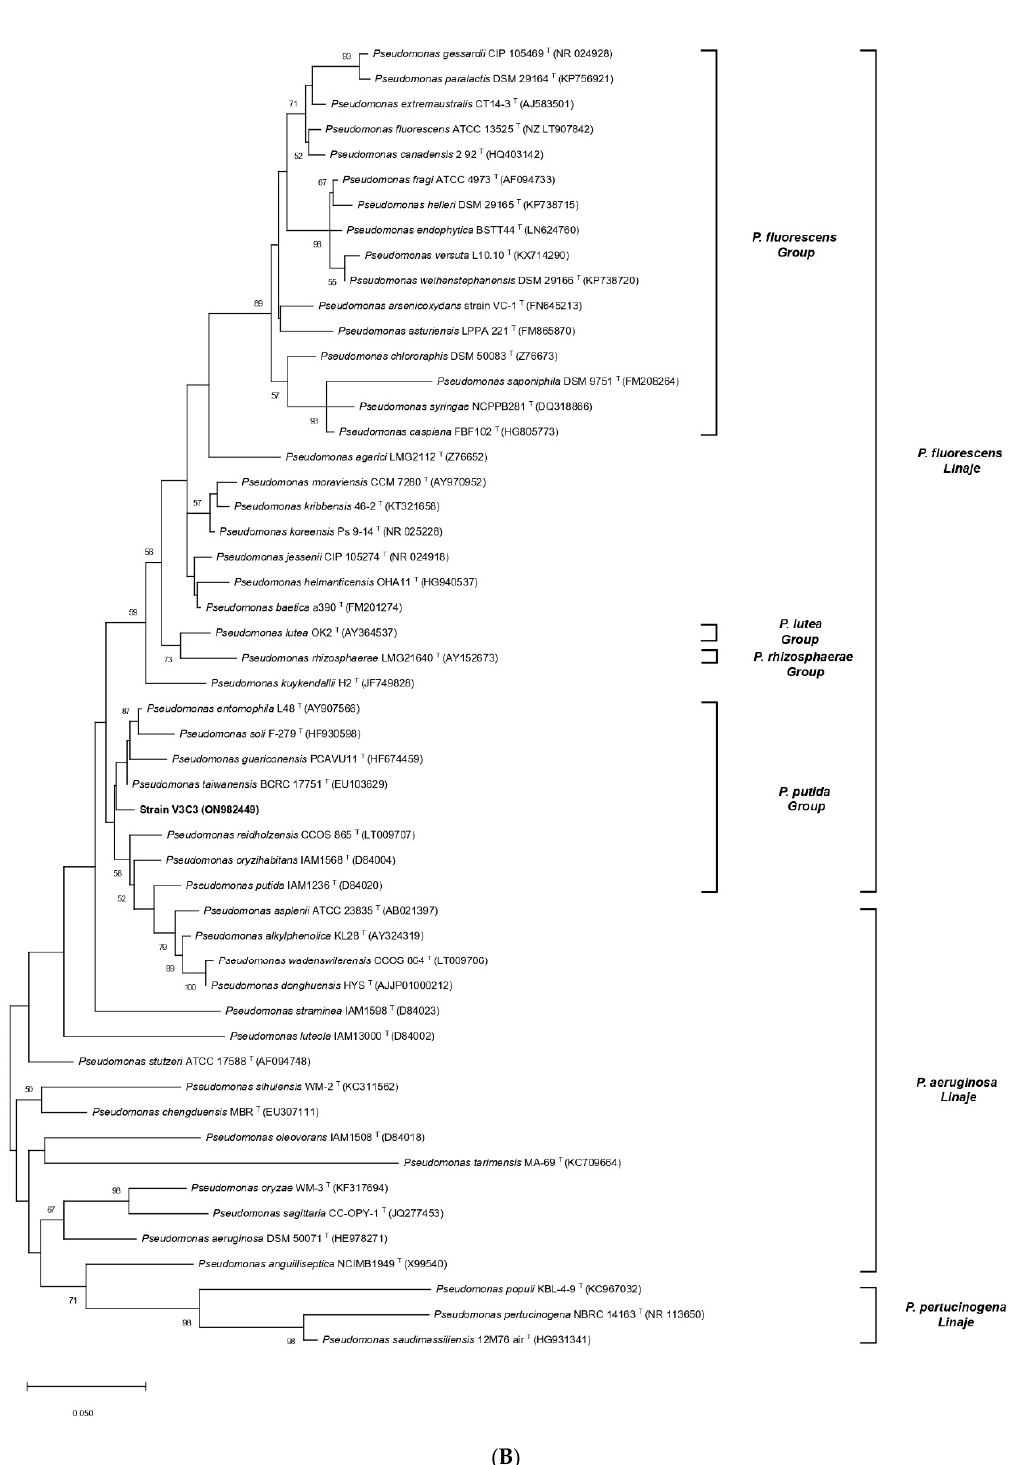
Figure 2. Maximum likelihood phylogenetic tree of the 16S rRNA gene for hypertolerant bacteria (HCdB) identification. The trees were constructed on the base of 16S rRNA sequences (1197 and 1395 nucleotides, respectively) of some species of Bacillaceae family ( A ) and Pseudomonas genus ( B ) reference sequences, using Kimura-2-parameter and gamma distribution models (G+I). Bootstrap values calculated for 1000 replications are indicated at the nodes. GenBank accession numbers are indicated in parentheses and bacterial clades are indicated in brackets. The complete tree of Bacillaceae members used is shown in Figure